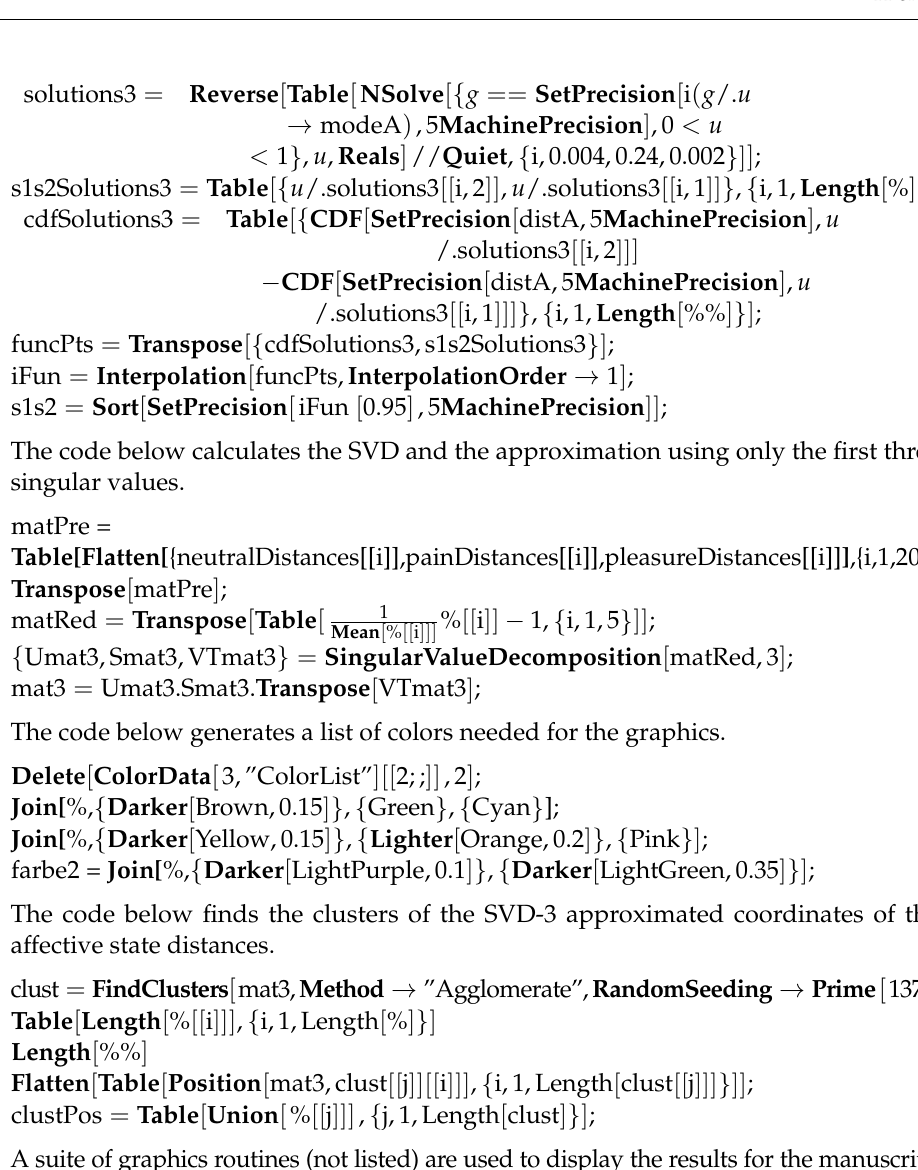
Table [ { CDF [ SetPrecision [ distA, 5 MachinePrecision ] , u /.solutions3 [[ i, 2 ]]] − CDF [ SetPrecision [ distA, 5 MachinePrecision ] , u